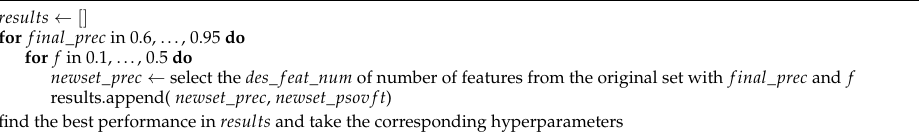
Algorithm 3 Experiments For Hyperparameter Selection